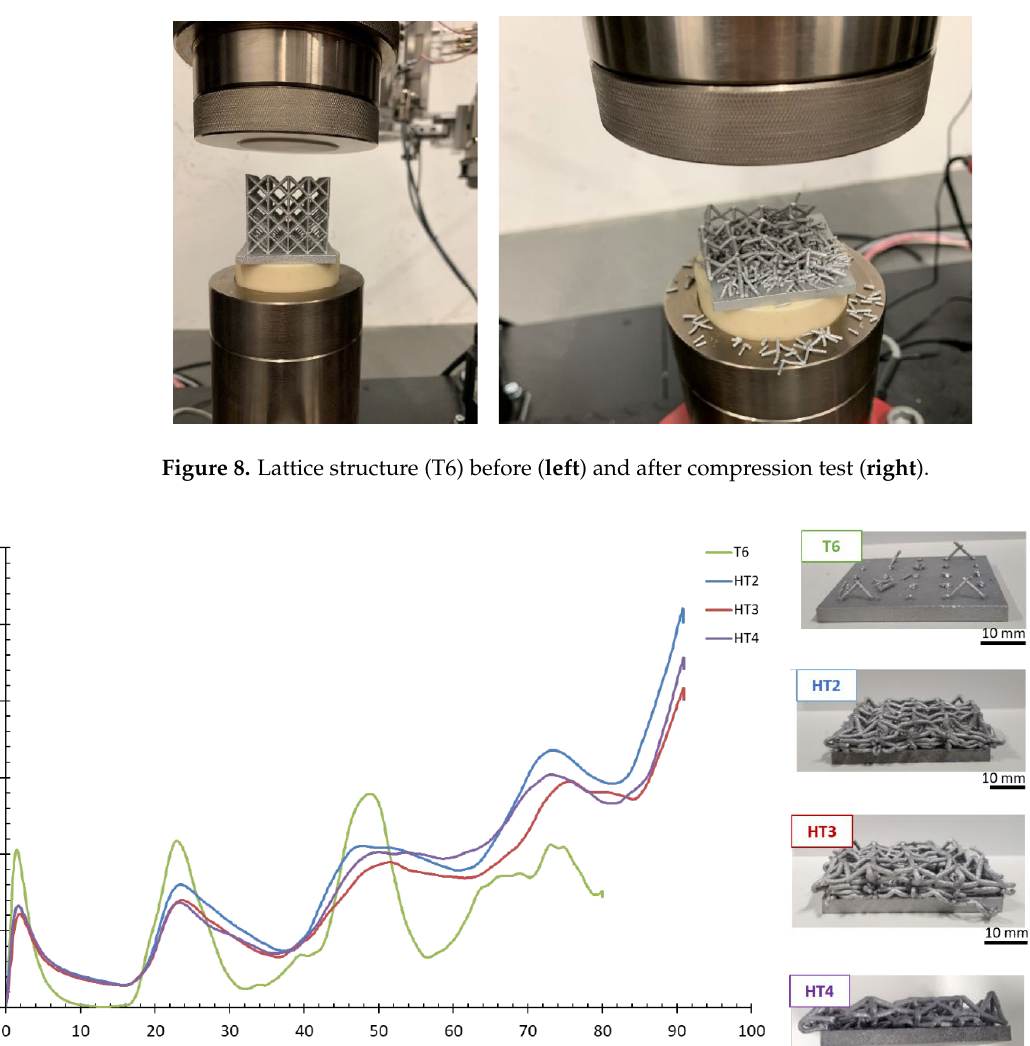
Figure 7. Force–displacement curves of the 3-point bending tests of as-built, T6 and HT2. The respective samples are shown on the right.